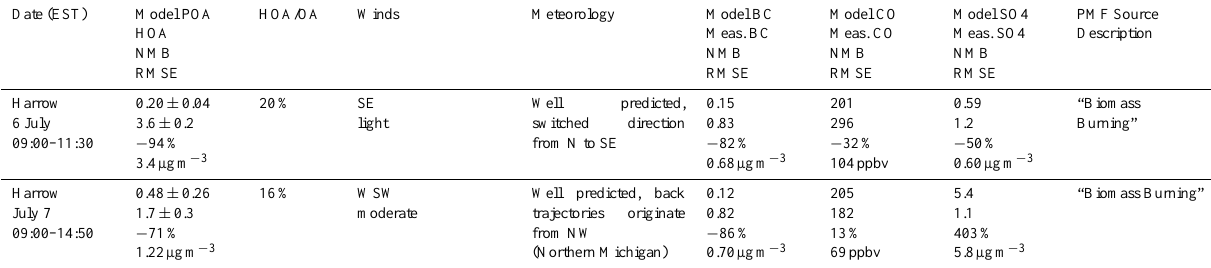
HOA/OA Winds Meteorology Model BC